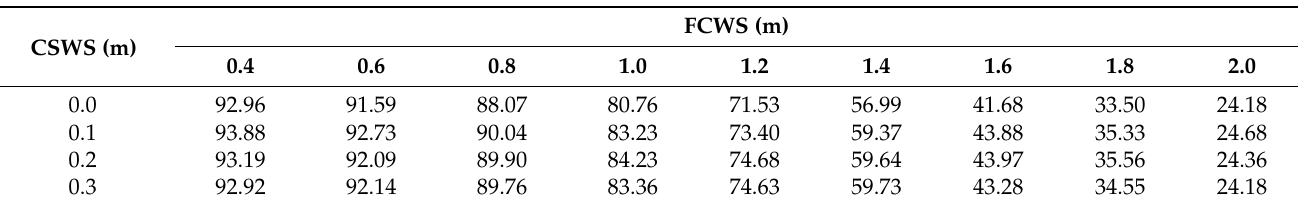
Table 3. The influence of different combinations of CSWS and FCWS on the recall (%) of C. equisetifolia detection.